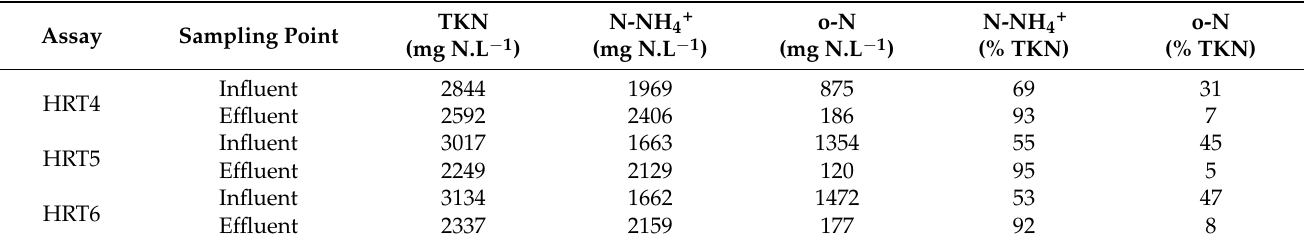
Table 4. Concentrations of TKN, N-NH 4+ , o-N, and relative proportions of N-NH 4+ , o-N in the influent and effluent of the DF bioreactor for all experimental